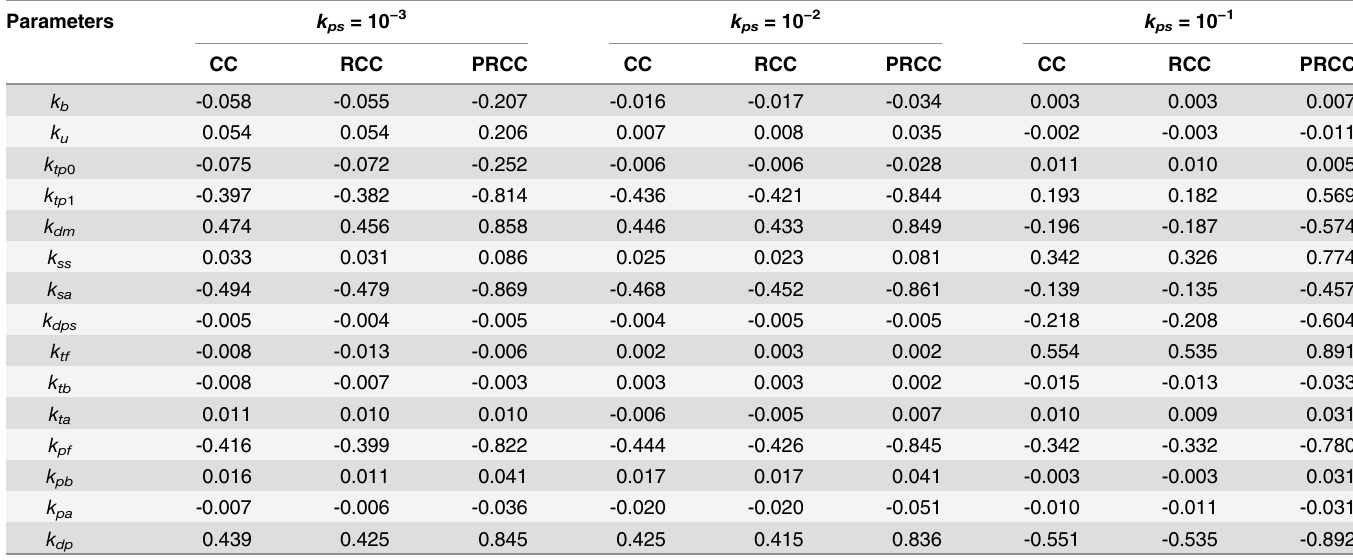
Table 2. CC, RCC, and PRCC values for all the input parameters with output β for low, medium and high values of k ps .